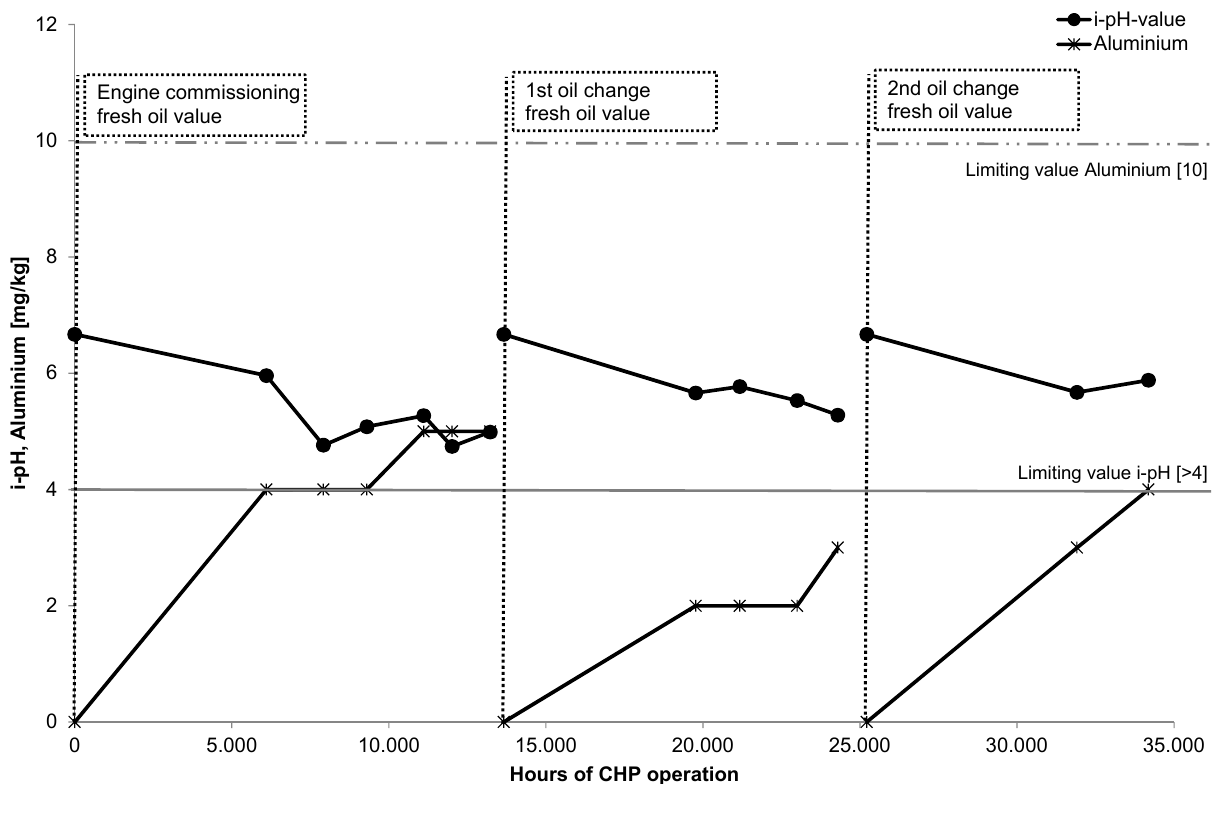
Figure 6. Results for i-pH and content of aluminum complemented by fresh oil values at times of oil